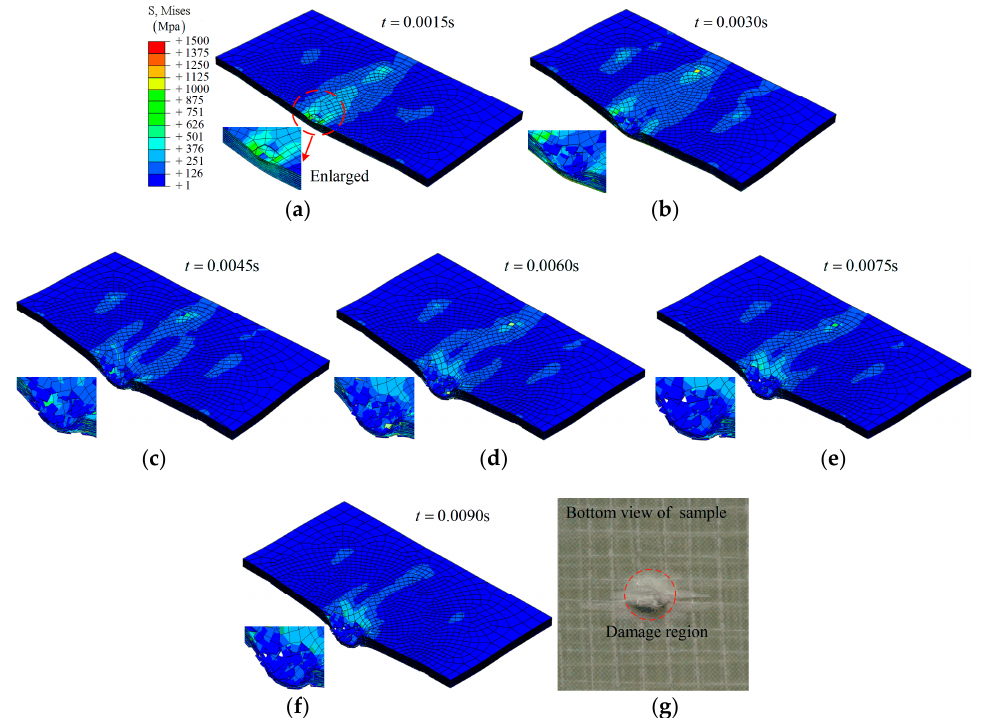
Figure 3. The simulation results on the composite laminates at different times (group A1), and the bottom view of the sample after impact: ( a ) t = 0.0015 s; ( b ) t = 0.0030 s; ( c ) t = 0.0045 s; ( d ) t = 0.0060 s; ( e ) t = 0.0075 s; ( f ) t = 0.0090 s; ( g ) bottom view of sample.